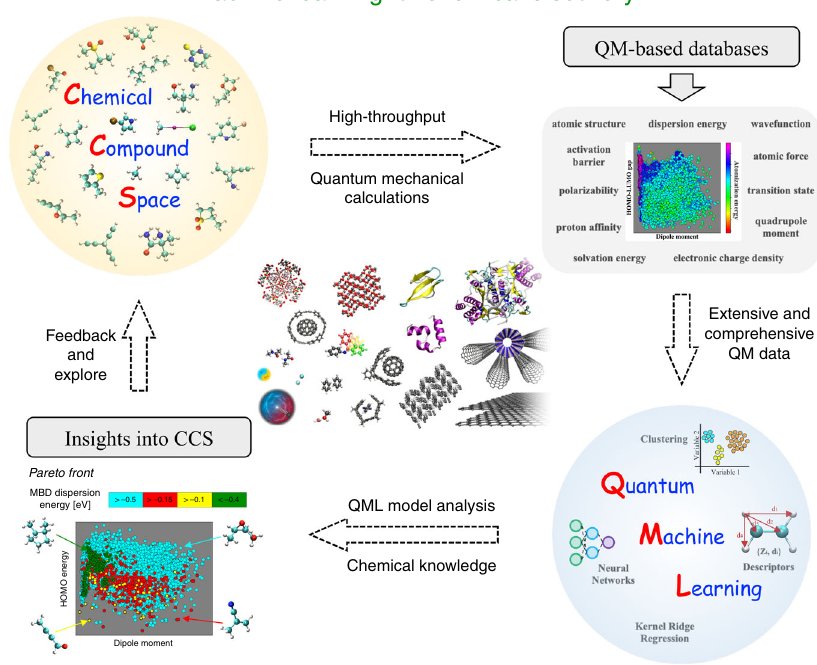
Fig. 1 Schematic illustration of using machine learning in the process of chemical discovery. Subsets of relevant chemical compound space (CCS) are sampled to create datasets of molecular structures. High-throughput quantum-mechanical (QM) calculations are subsequently used to construct QM molecular property datasets. Quantum machine learning (QML) algorithms are employed to enable interpolation and analysis of QM properties in CCS. QML model analysis is combined with chemical knowledge to extract insights into CCS, for example by constructing and analyzing Pareto fronts. Finally, the CCS can be further extended and explored with the accumulated knowledge from QML. The main applications of QML up to now cover CCS of small molecules and ordered extended solids. However, the applicability of QML should be further extended to biomolecular systems, nanostructures, surfaces, organic framework materials, supramolecular systems, and even quantum-mechanical model systems (see central